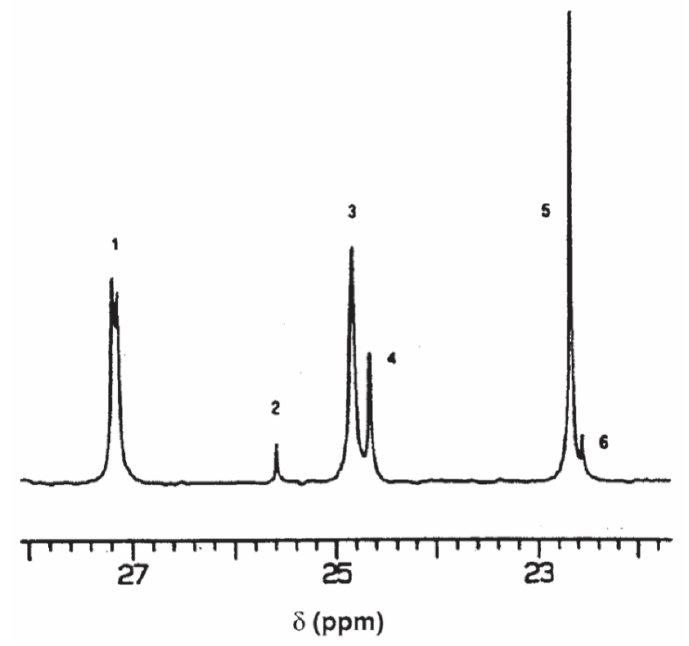
Figure 5. 13 C NMR spectrum of the aliphatic carbons in palm oil containing FFA, in CDCl 3 solution (concentration 1:3, v / v ). Peak 1: allylic carbons of oleic and linoleic acyls in both triglyceride (TG) and FFA. Peak 2: C11 of linoleic acid. Peak 3: C3 of all acyl chains in TG. Peak 4: C3 of FFA. Peak 5: C15 of palmitic, C17 of stearic, and C17 of oleic acids in TG. Peak 6: C17 of linoleic acid in TG. The spectrum